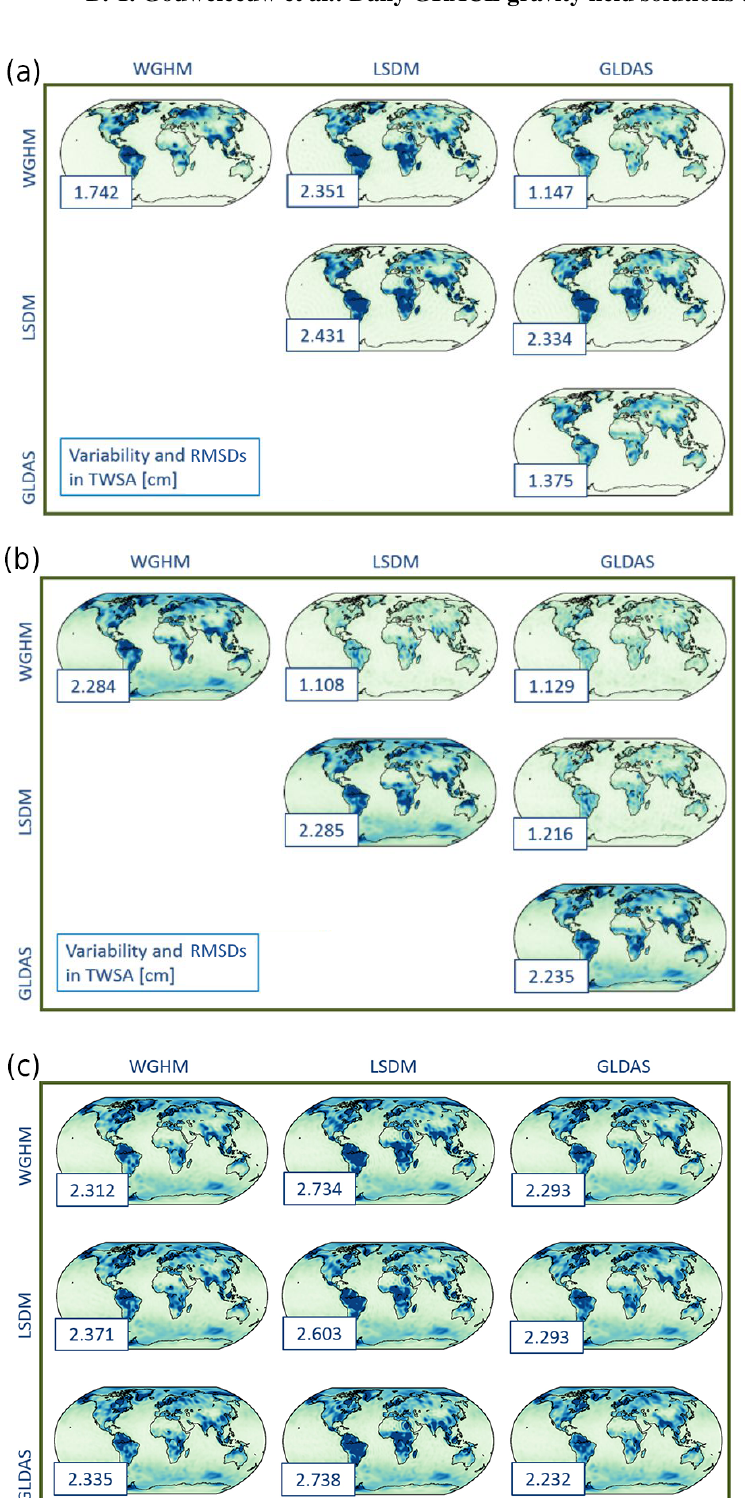
Figure 1. (a) Global average daily water mass variability (main diagonal) and root mean square differences (RMSDs) (off-diagonal) between the hydrological models used, expressed as TWSAs (2003–2014, secular and annual variations removed). (b) Global average daily variability (main diagonal) and RMSDs (off-diagonal) of the derived daily ITSG-Grace2014 solutions, expressed as TWSAs (2003–2014, secular and annual variations removed). (c) Global RMSDs in cm between the daily ITSG-Grace2014 solutions (rows) and the hydrological models used (columns), expressed as TWSAs (2003–2014, secular and annual variations